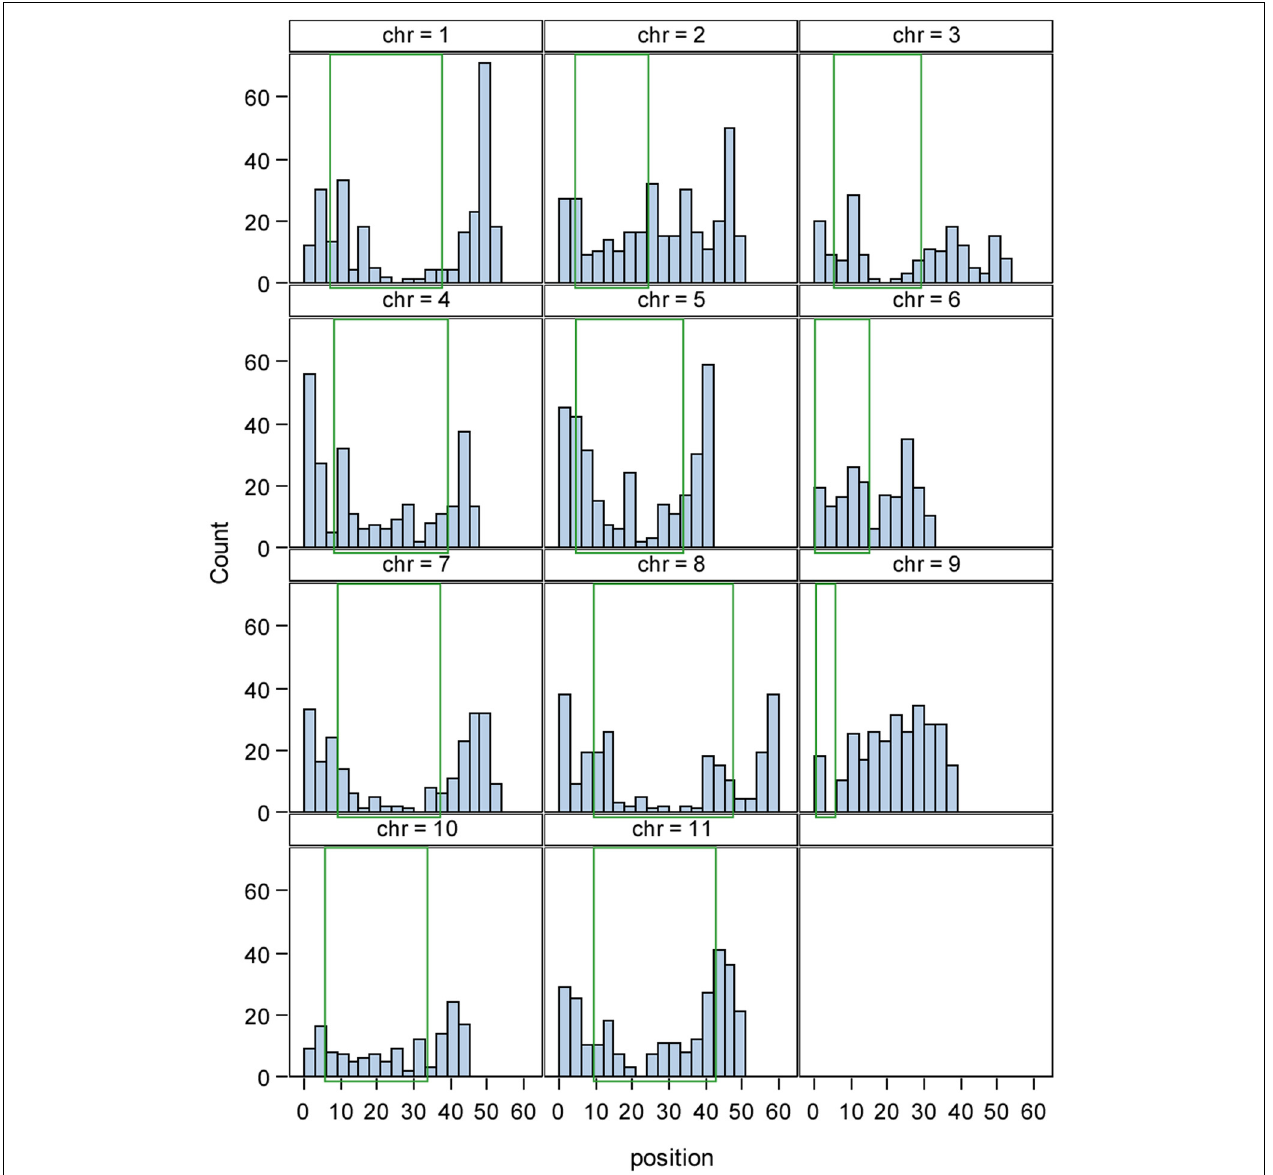
FIGURE 2 | Physical distribution of 2687 InDel markers across 11 chromosomes of common bean. The x axis shows the chromosome length in Mbp and the y axis represents the frequency of InDel markers. The green rectangle indicates the pericentromeric region in each chromosome.